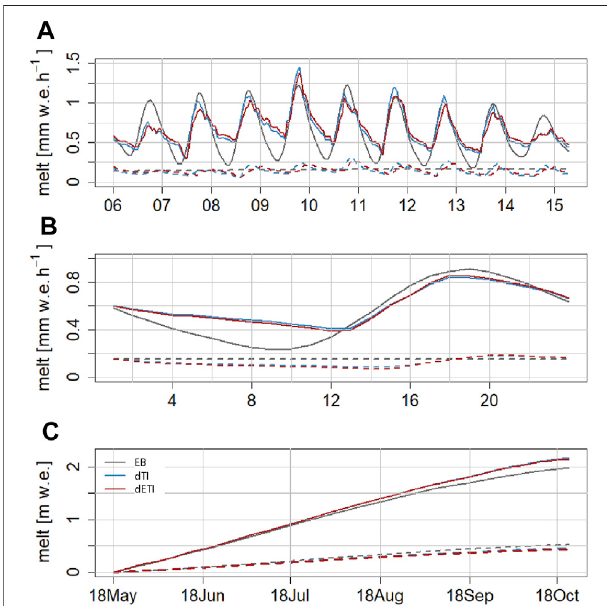
FIGURE 13 | Melt curves for two pixels with a debris thickness of 36 (solid) and 181 cm (dashed lines) respectively during nine days in June 2013 (A) , the diurnal cycle over the whole season (B) and cumulatively over the whole season (C) , calculated with the full energy balance model as well as the two index models.